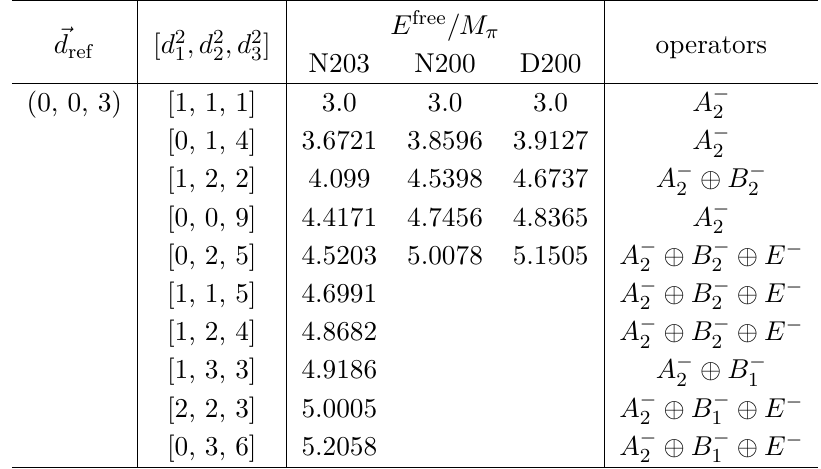
Table 23. Same as table 21 except for the three-pion operators with ~d 2